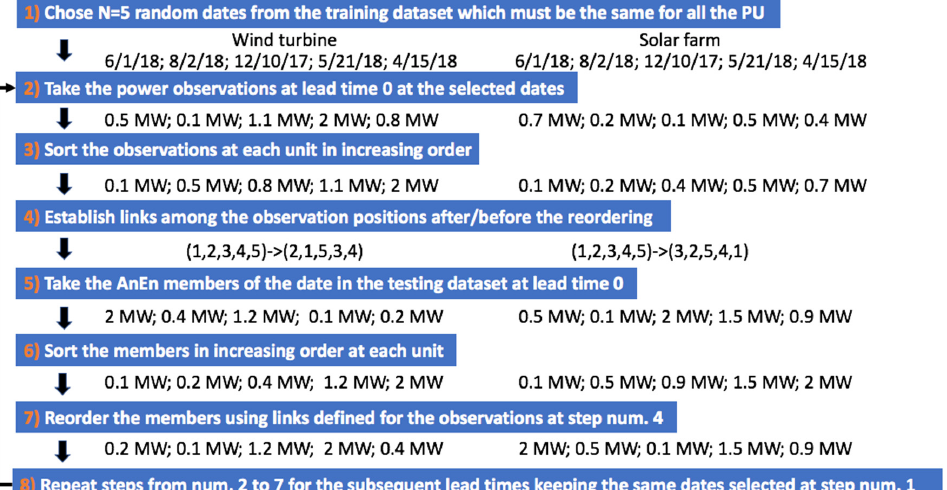
Figure 3. Main steps of the Schaake shuffle algorithm. For sake of simplicity, only 5 ensemble members and 2 production units (1 solar farm and 1 wind turbine) are shown in this description.